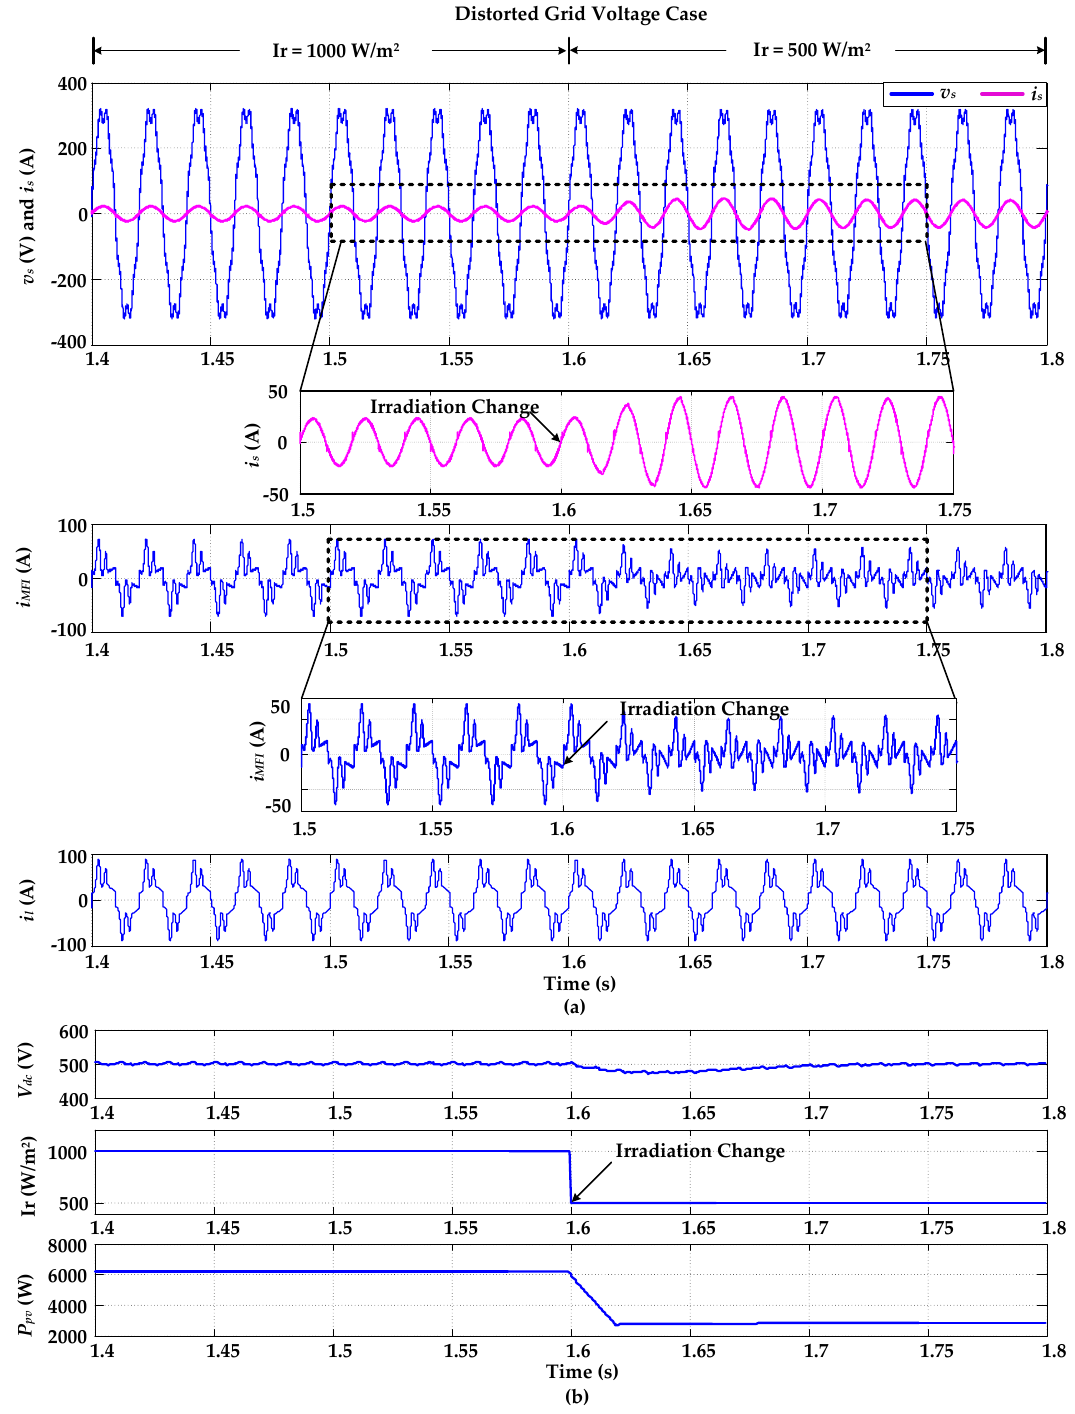
Figure 11. Dynamic response at PCC during grid sharing and power conditioning; ( a ) distorted grid input voltage, current, MFI current, and load current; ( b ) MFI DC-link voltage, solar irradiation, and PV power under the distorted grid.